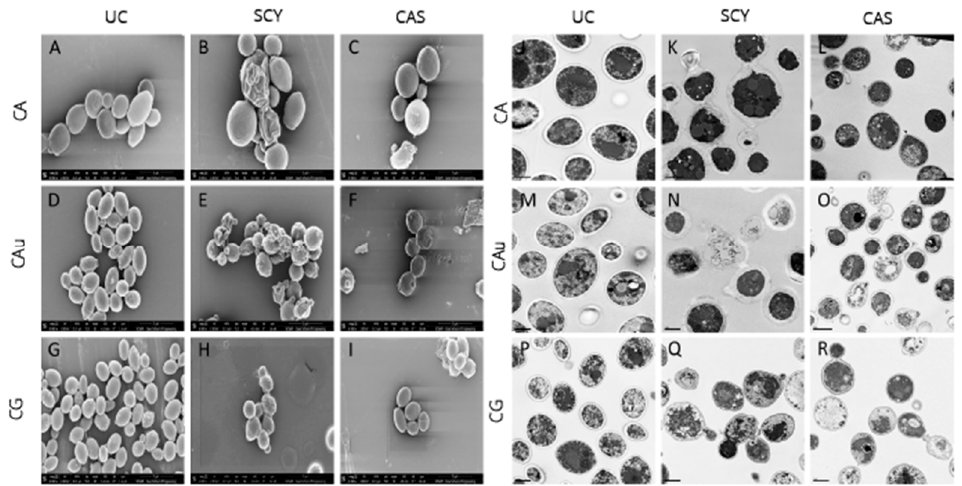
Figure 3. Scanning electron microscopy of untreated cells (panels ( A , D , G )), cells treated with ibrexafungerp (panels ( B , E , H )), and cells treated with caspofungin (panels ( C , F , I )) (Hager et al., 2018)